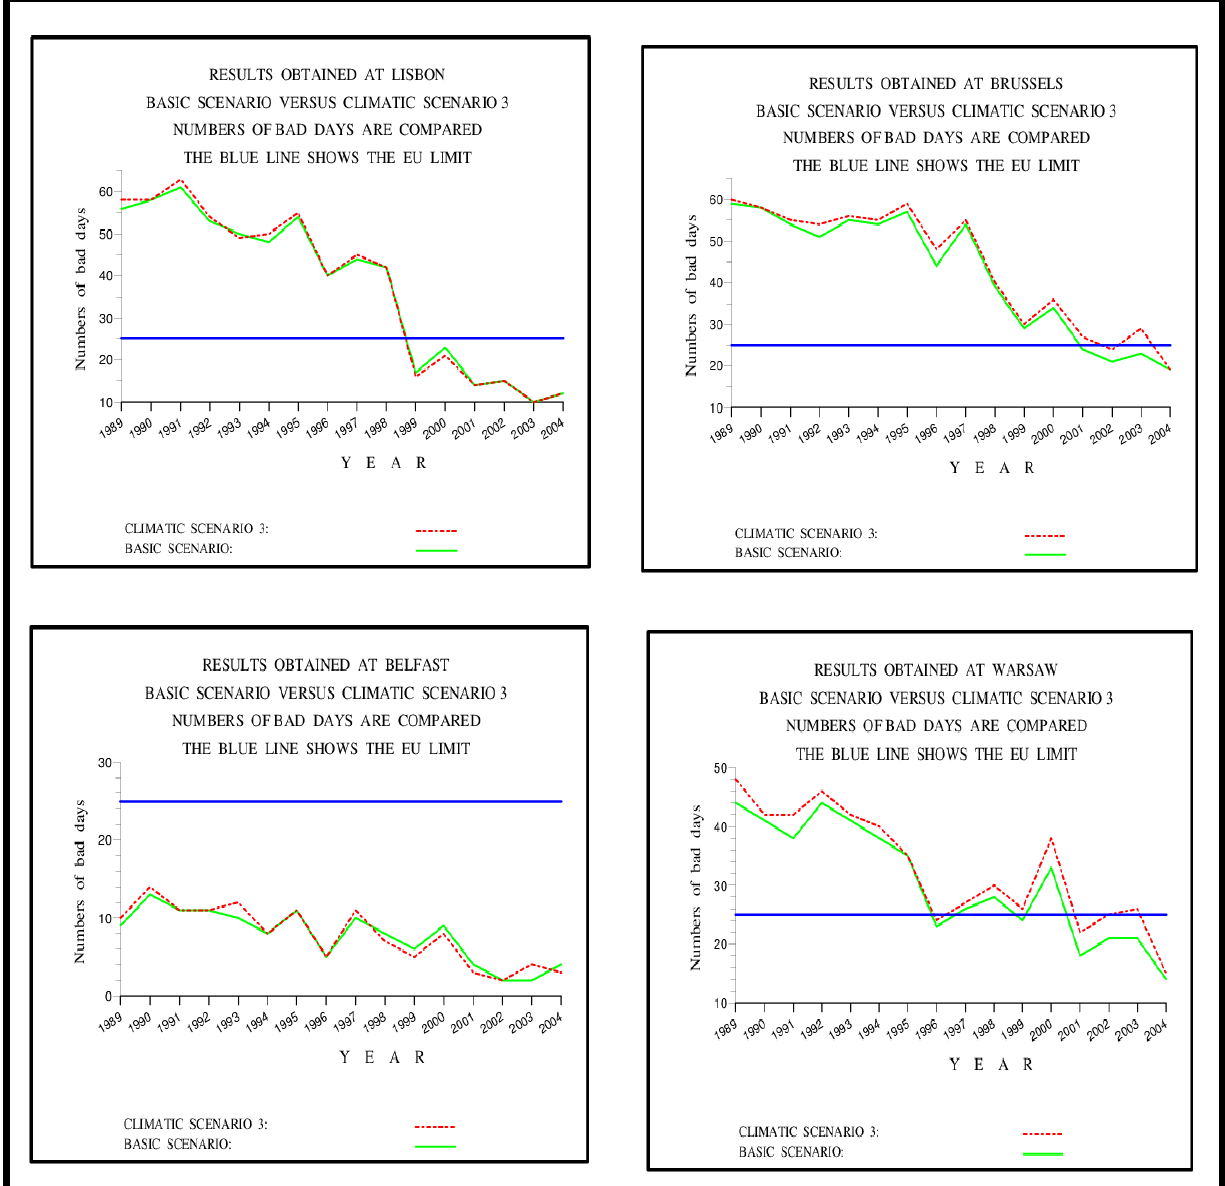
Figure 5. Variations of the numbers of “bad days” in Lisbon, Brussels, Belfast and Warsaw during a time-period of 16 consecutive years obtained when UNI-DEM is run with two scenarios. The Third Climatic Scenario is again giving in most of the cases more “bad days” than the Basic Scenario.